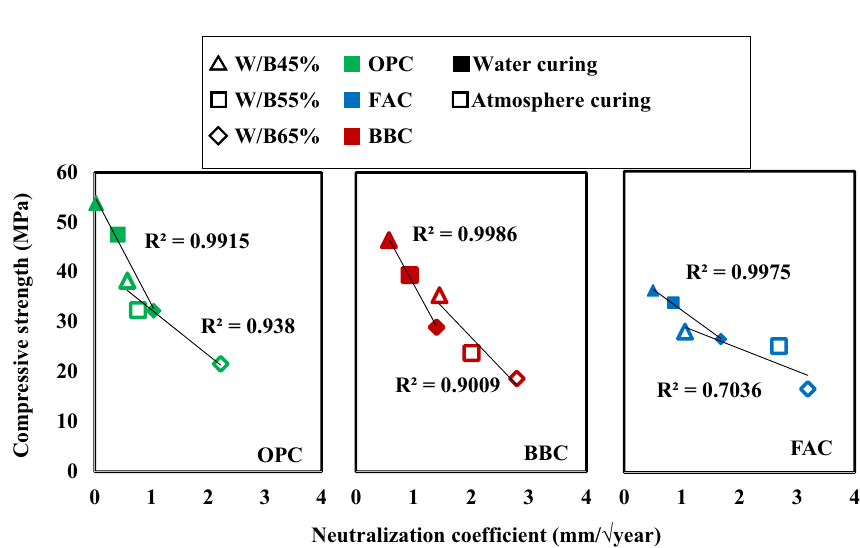
Fig. 6 Compressive strength versus neutralization coefficient.